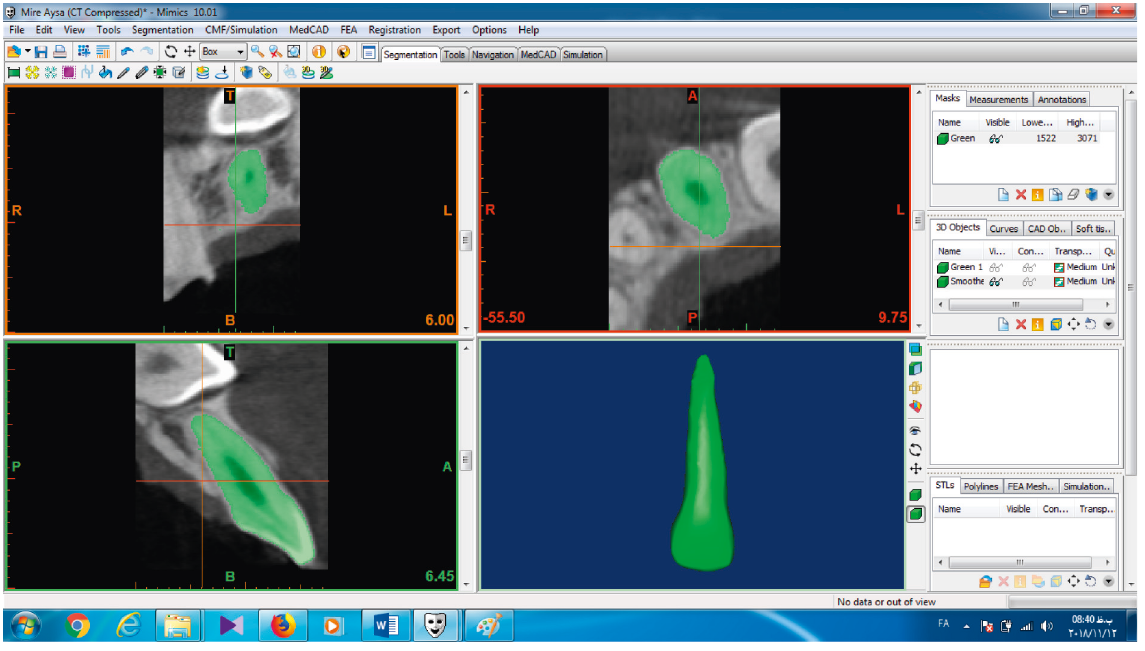
Figure 2: 3D view of maxillary lateral of the impacted side.